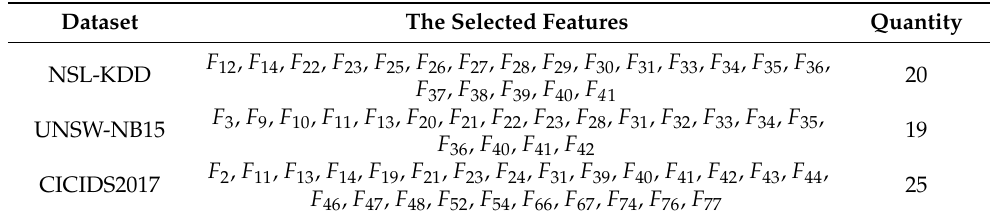
Table 3. The selected features based on the chi-square filtering technology.